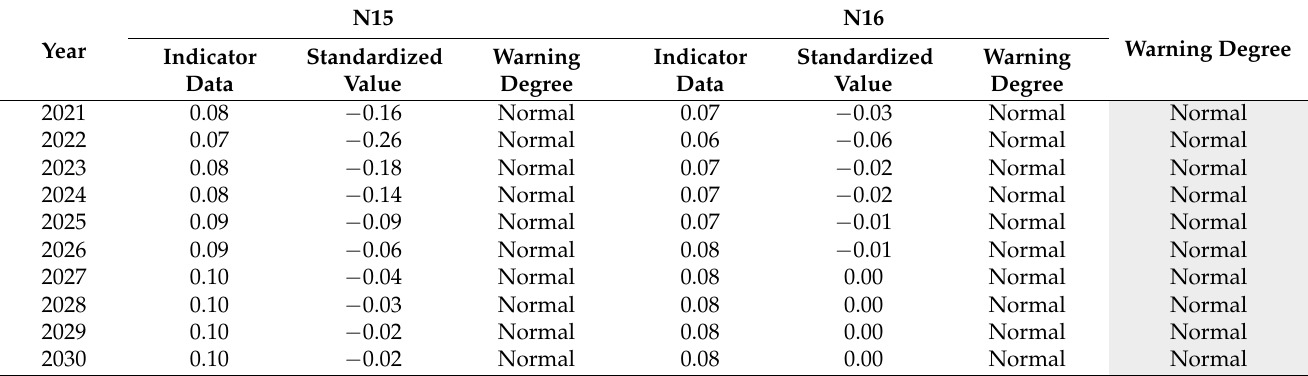
Table 6. The predicted warning status of the Beijing real estate market from 2020 to